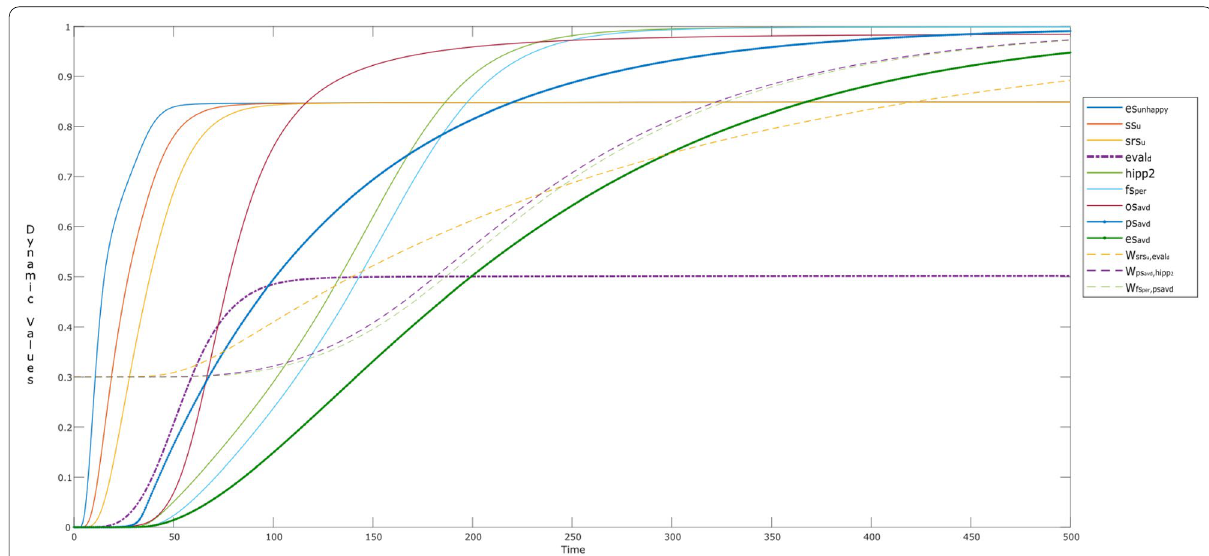
Fig. 10 Coping with the narcissistic parent while (s)he is unhappy (input: es unhappy